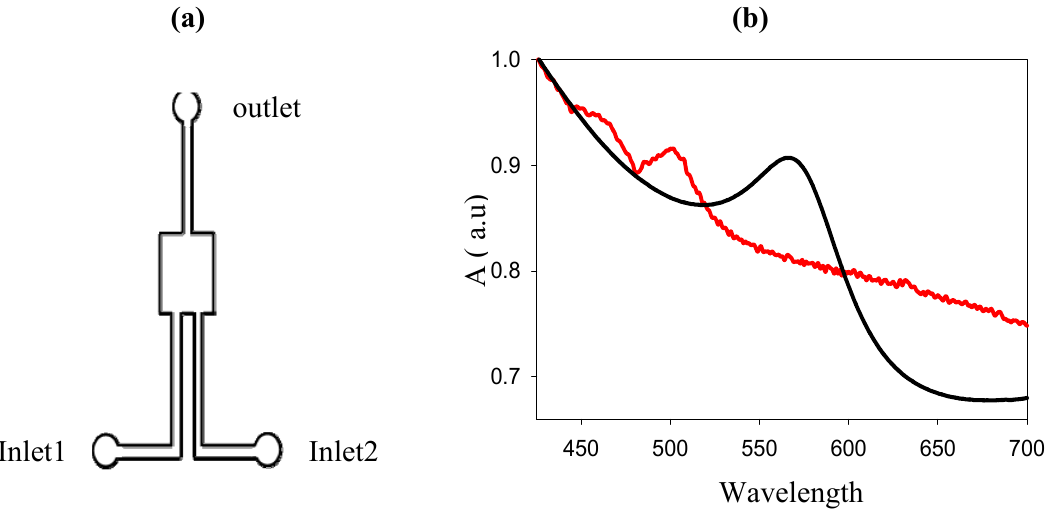
The copper sulfate solution (2.7 × 10 − 3 M) is mixed with 4 mL of a sodium citrate solution (1%) outside the micro-reactor and then introduced into the micro-reactor, simultaneously with a sodium